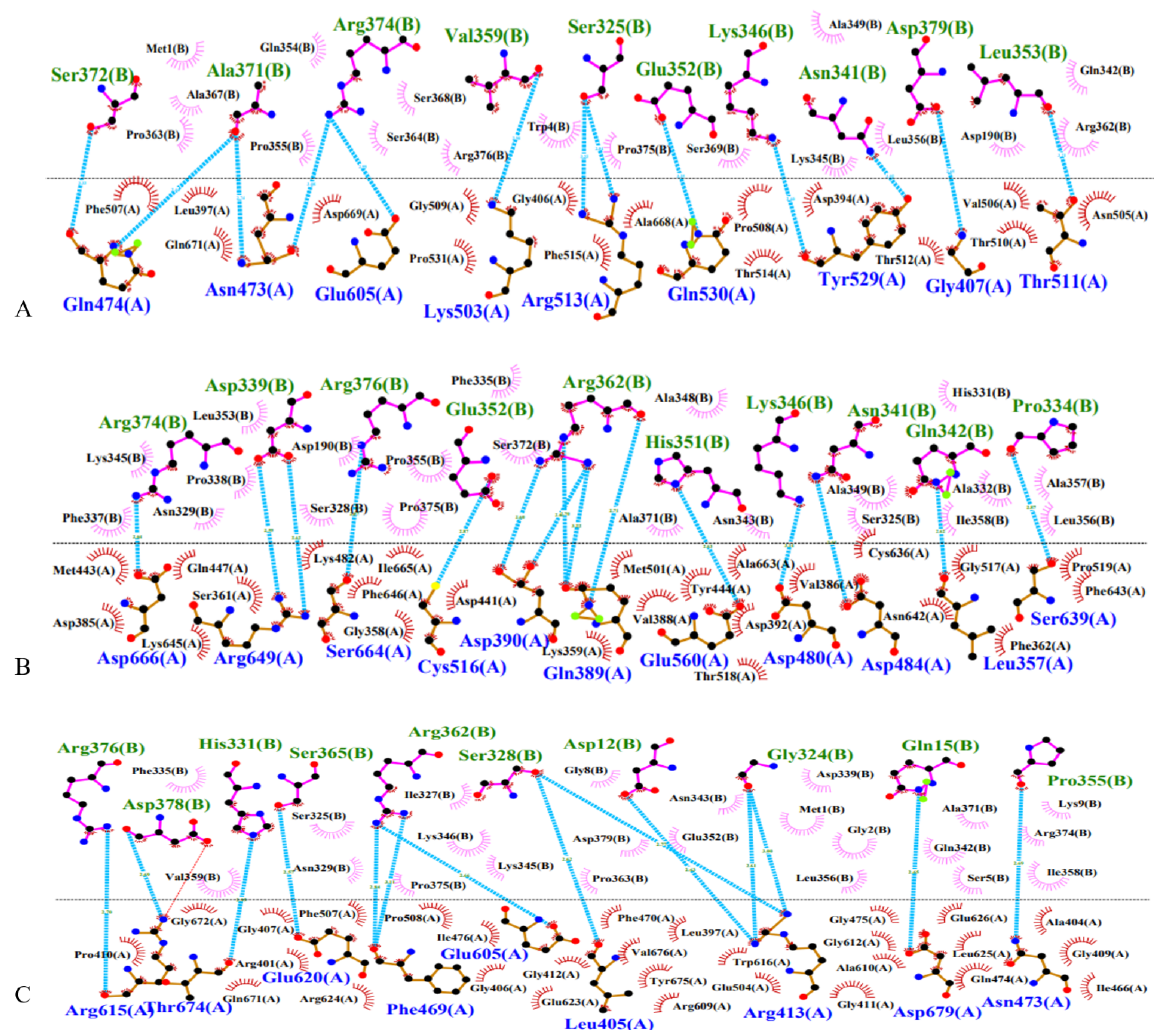
Figure 2. Post-docking interactions between active site residues of protein PKCγ with connexin 43: ( A ) Wild PKCγ interaction with connexin 43; ( B ) Mutant PKCγ (A24S) with connexin 43; and ( C ) Mutant PKCγ (K359R) with connexin 43 .